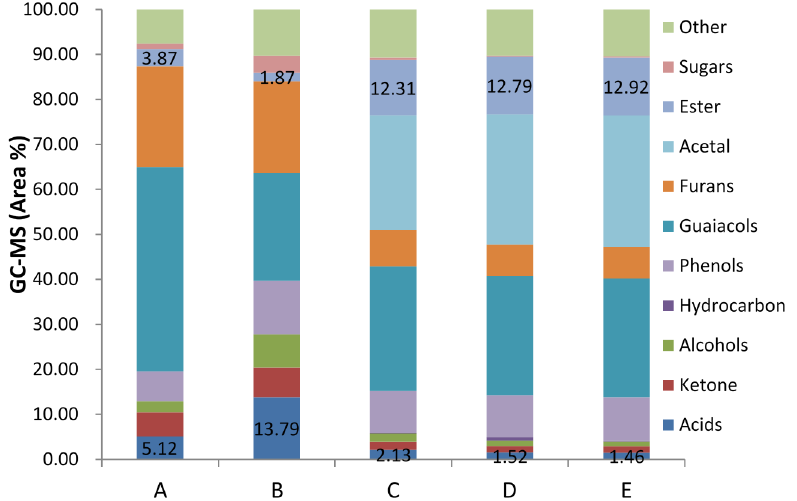
Figure 2. Chemical distribution of water-phase esterification process on ZSM − 5 catalyst with methanol: ( A ) Water-phase after water separation; ( B ) Water phase after Liquid-liquid extraction process (feedstock); ( C ) Esterification result with 2% ZSM − 5 at temperature of 80 °C; ( D ) Esterification result with 2% ZSM − 5 at temperature of 100 °C; ( E ) Esterification result with 5% ZSM − 5 at temperature of 100